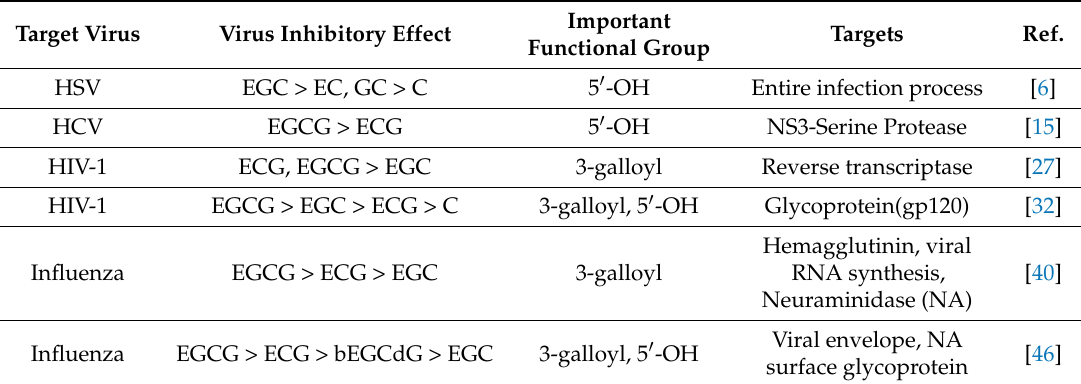
Table 5. Comparison of Antivirus Activity of Natural